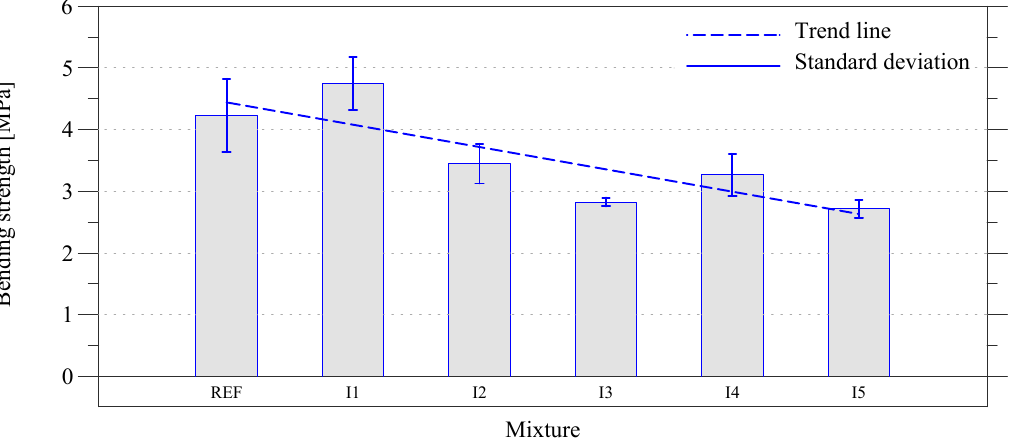
Figure 4. Bending strength of tested specimens.